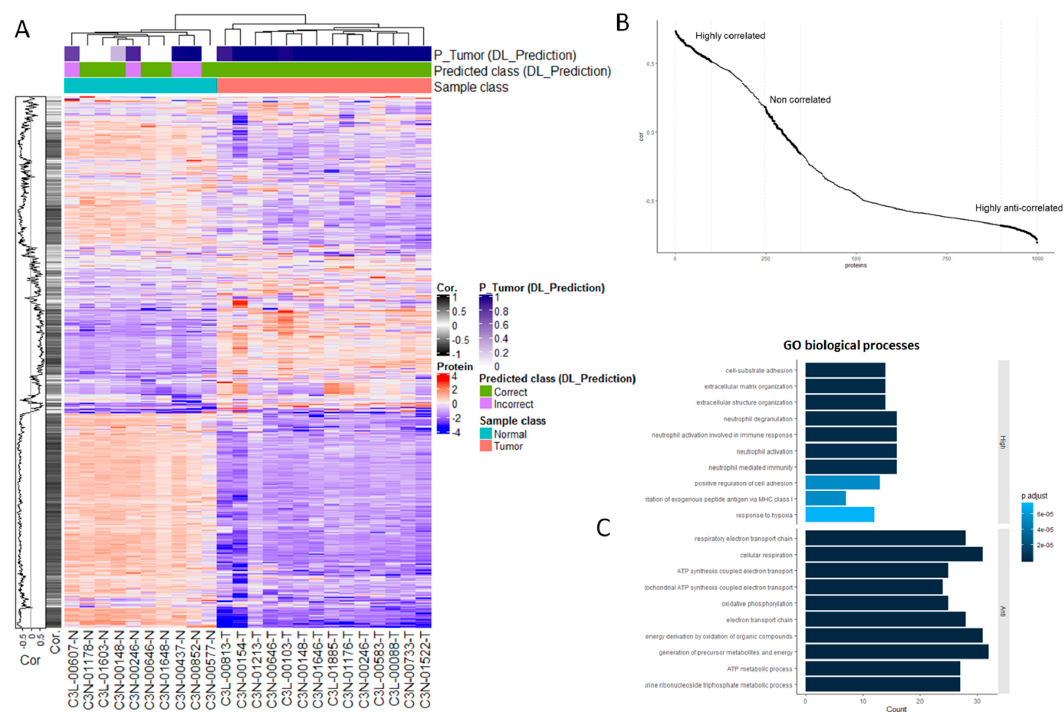
Figure 2. Proteomic markers are correlated with histology-based predictions. ( A ) Heatmap of proteomics data (vertical axis: Expression values for 997 proteins) measured in 24 samples in our independent test set (horizontal axis). The top of the heatmap specifies the true and predicted classes (normal and tumor samples), as well as the corresponding p -values of assigning a sample to the tumor class, as predicted by our histology-based DL model. The plot on the left side of the heatmap depicts the correlations between each protein and the predictions generated by the histology-based DL model ( p -values of tumor classification). ( B ) Plot showing the correlations between each protein expression and the predictions generated by the histology-based deep learning (DL) model ( p -values of assigning an image to the tumor class). Correlation values are ranked from the highest positive to lowest negative (anti-correlated) values. ( C ) Gene ontology (GO) enrichment analysis of proteins highly positively- and anti-correlated with the histology-based predictions. Bars indicate the magnitude of the enrichment scores, and adjusted p -values of the enrichments are color coded. Statistically enriched GO terms were not detected for proteins whose expression values were weakly correlated with histology-based predictions (i.e., those with correlations around 0).